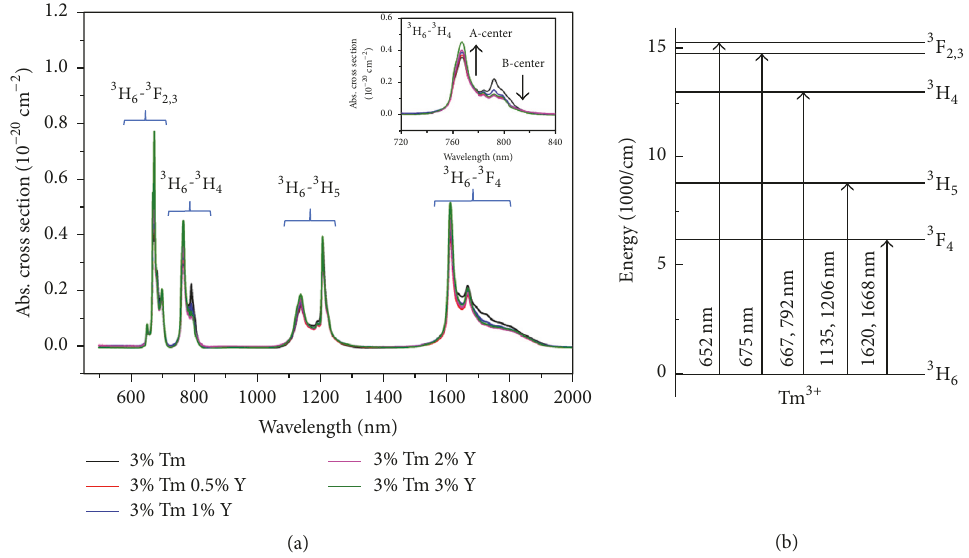
Figure 2: Absorption spectra (a) and energy level diagrams (b) of 3 at.% Tm, 𝑥 at.% Y:CaF 2 crystals at 300